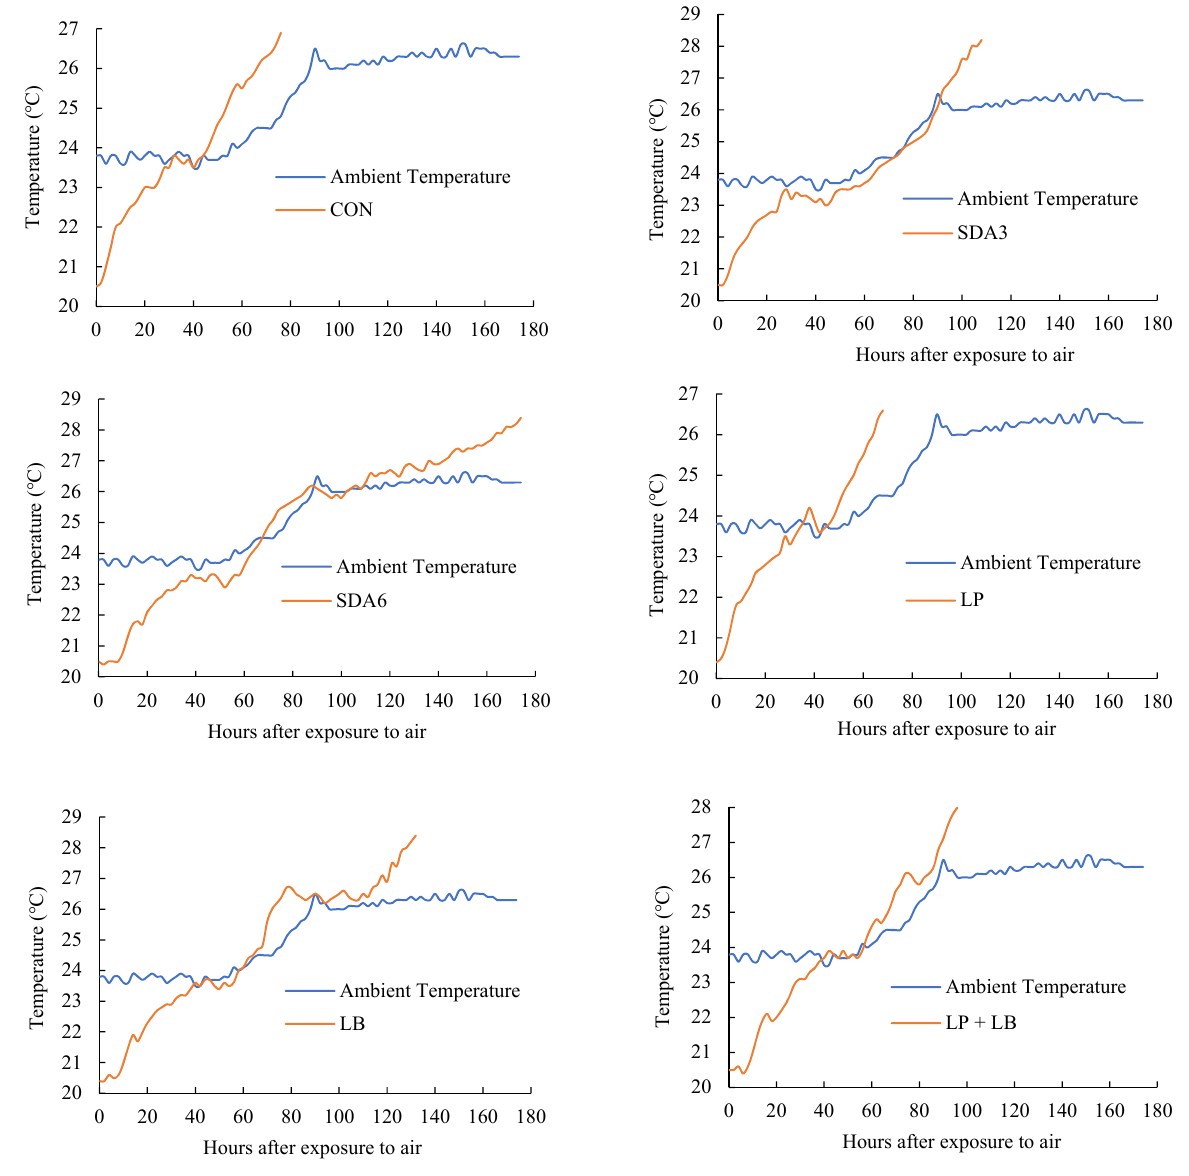
Figure 2. Temperature dynamics during aerobic exposure in early-harvested rye ensiled for 60 d with different additives. Treatments were untreat - ed silage (CON); SDA3 = sodium diacetate at 3 g/kg fresh weight; SDA6 = sodium diacetate at 6 g/kg fresh weight; LP = L. plantarum ; LB = L. buchneri ; LP+LB = L. plantarum + L. buchneri (equal proportion). Inoculant application rate was 1,000,000 cfu/g fresh weight.